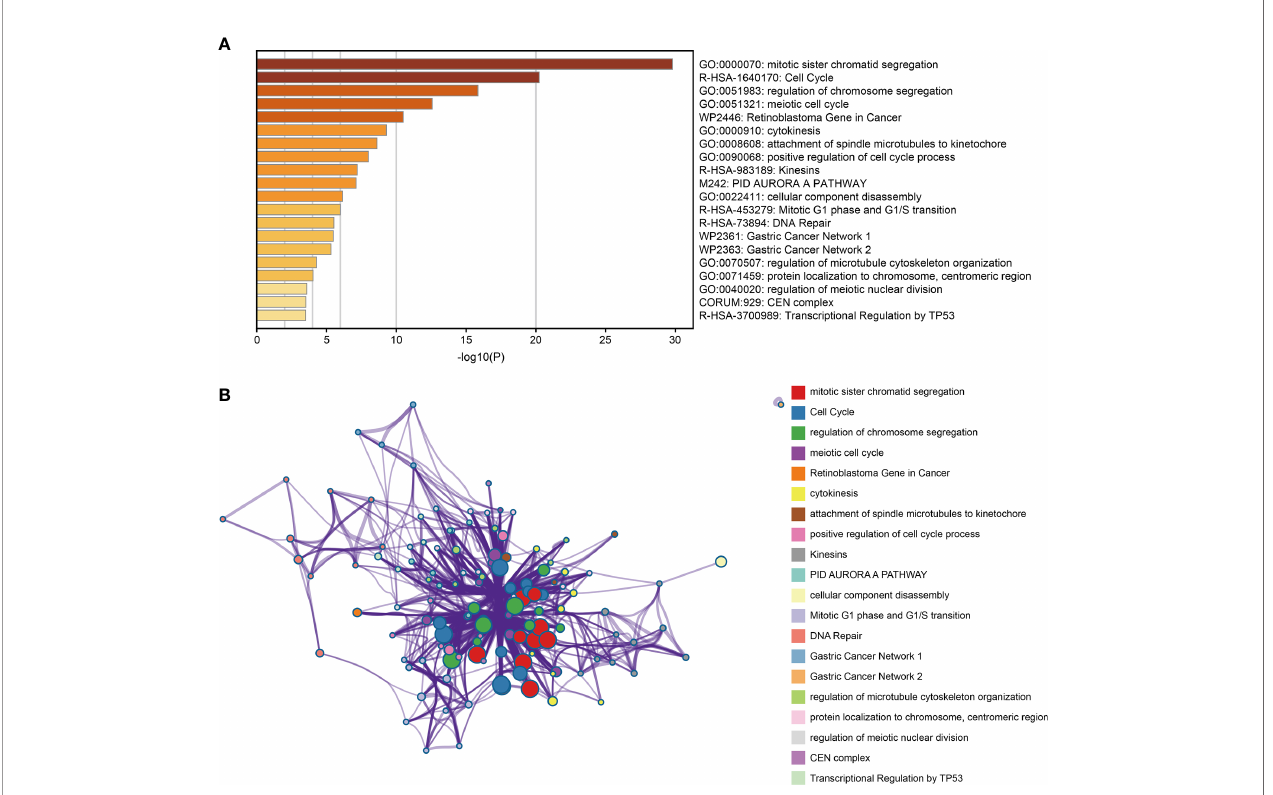
FIGURE 4 | Functional enrichment analysis of co-expression gene. (A) Bar plot of the signi fi cantly top 20 terms enriched. (B) Network relationship plot between terms and